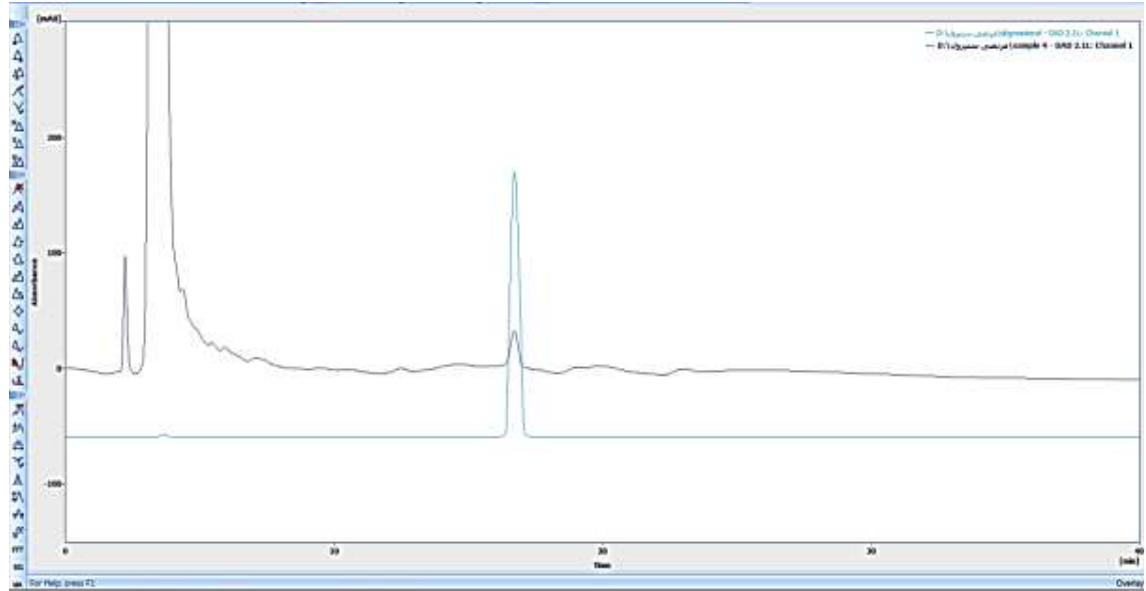
Figure 4. HPLC chromatogram analysis fractions contain stigmasterol [Standard stigmasterol (-) sample (-)]. The retention time for isolated compound and stigmasterol standard is identical (16.9).